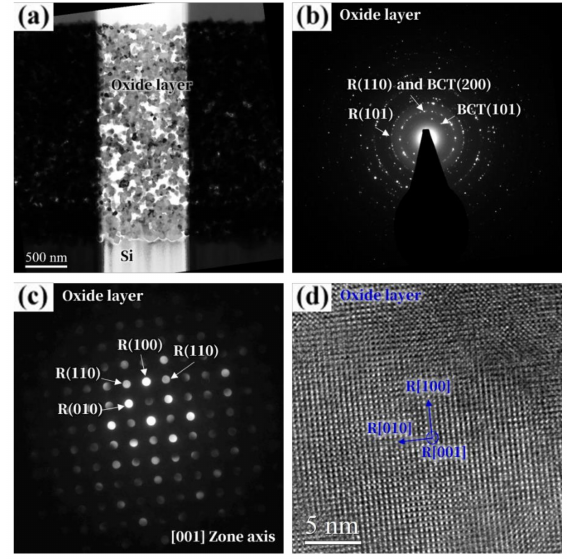
Figure 7. Cross-sectional TEM micrographs of the as-deposited (CrTaTiVZr)N coatings after annealing at 600 ◦ C in air. ( a ) bright-field image, ( b ) SAD pattern of the oxide layer, ( c ) NBD pattern of the oxide layer, ( d ) HRTEM lattice